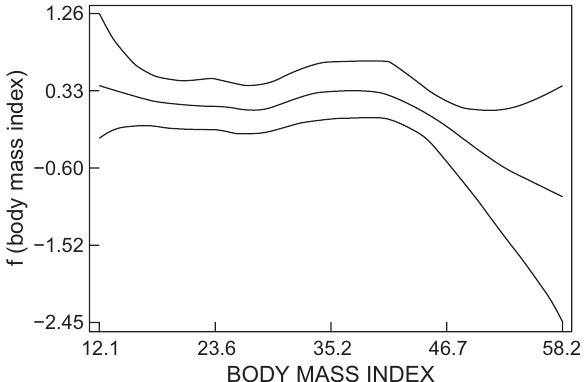
Figure 2: Nonlinear effect of BMI on unmet need for FP at 95% CI.